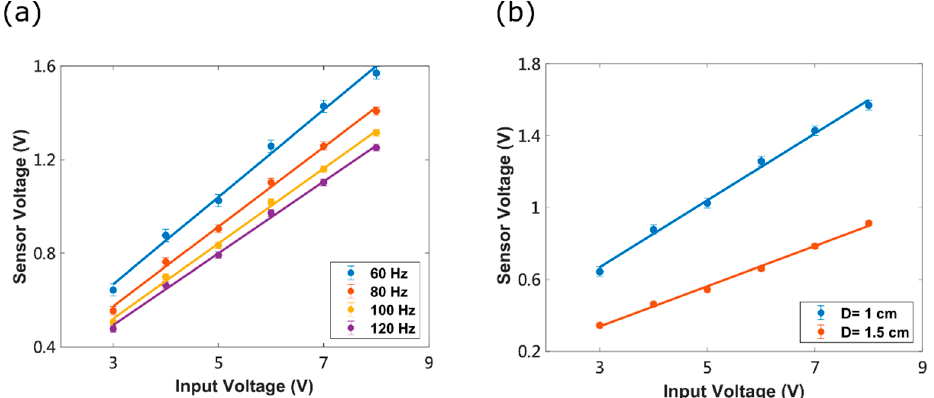
Figure 6. Measured RMS signal voltage versus function generator input RMS voltage. The solid dots are the measured data, whereas the solid lines are fitted linear function. ( a ) The RMS voltage signals versus RMS input voltage are plotted at 60, 80, 100, and 120 Hz. The largest linear regression error is ~27 mV. ( b ) The RMS voltage signals are plotted against RMS input voltage with a FBG to solenoid distance D of 1 and 1.5 cm. The linear regression error is ~15 mV.